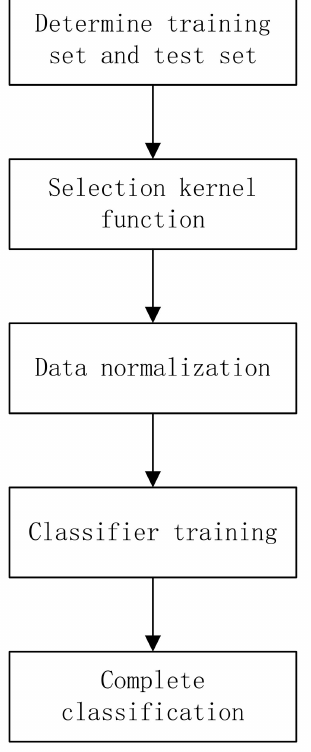
Figure 28. Flow chart of SVM Classification.